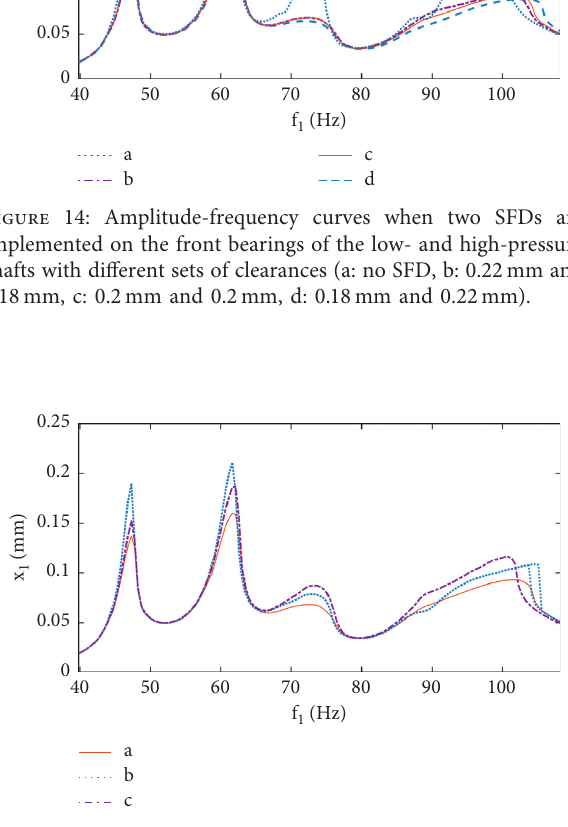
Figure 15: Comparisons of different SFD implemental configu- rations (a: two SFDs, b: one front low-pressure SFD, c: one front high-pressure